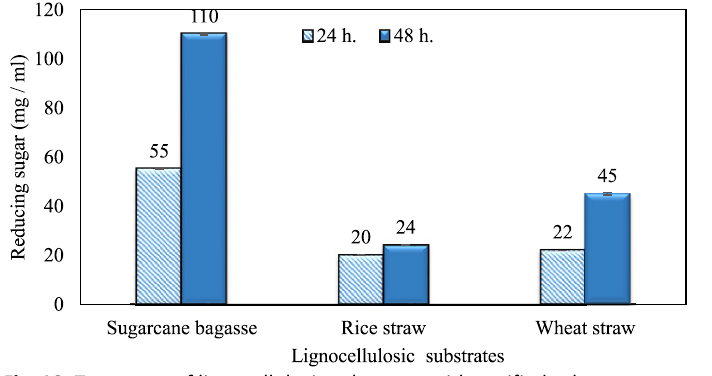
Fig. 18. Treatment of lignocellulosic substrates with purified xylanase Table 7. Effects of crude extraction of P. janthenellum and T. viride on fungal and bacterial activities Biological Tested organisms Diameter of inhibition zone (mm)